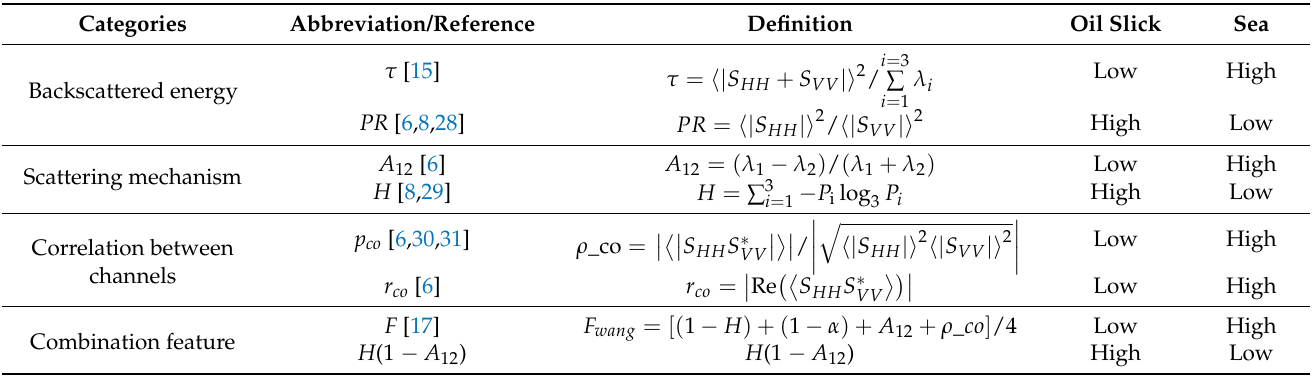
Table 3. Details of the four categories of general polarimetric features investigated in this study, including their reference, definitions and expected behavior over oil slicks and the sea.